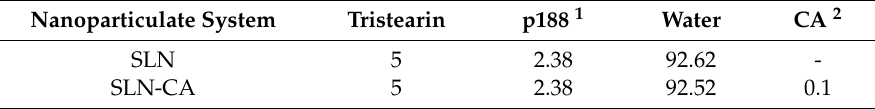
Table 1. Composition of the indicated formulations, expressed as percentage by weight. Nanoparticulate System Tristearin p188 1 Water CA 2